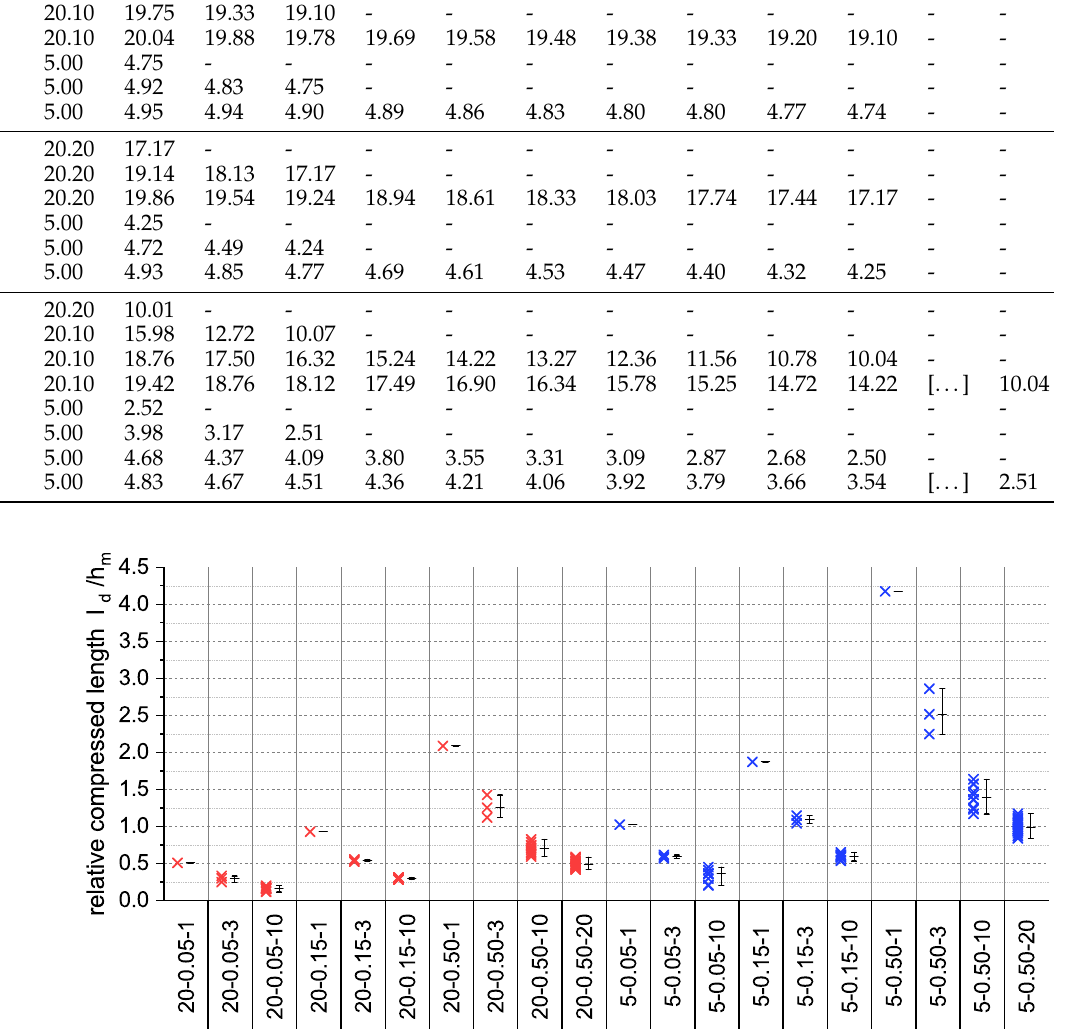
Figure A2. Calculated relative compressed length for second series of experiments.